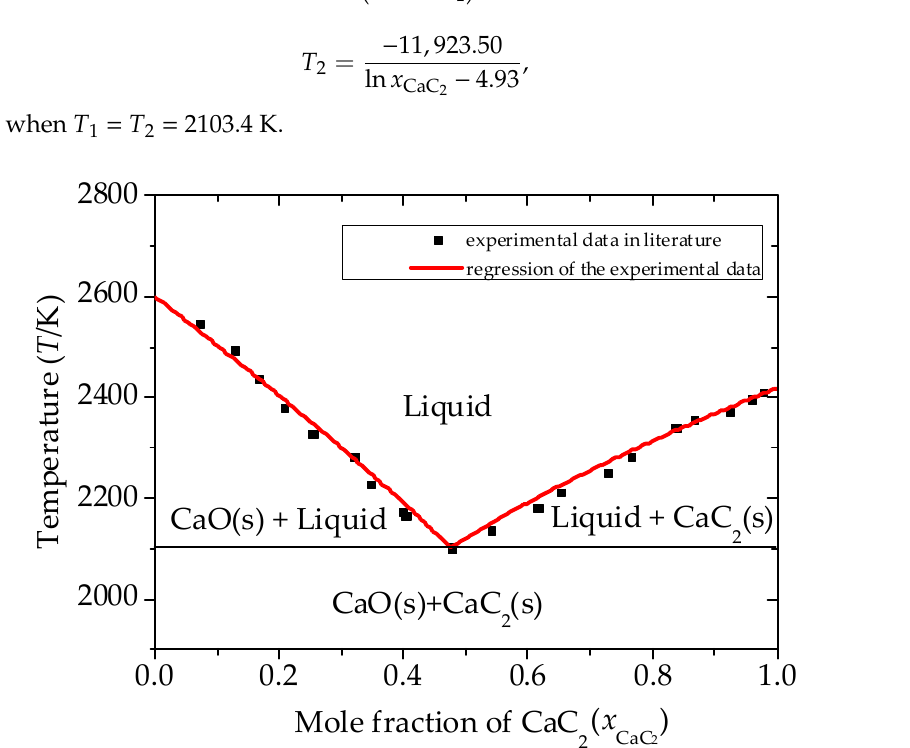
Figure 2. Experimental data fitting of phase diagram of CaC 2 -CaO binary system (Liquid contains CaO (l) and CaC 2 (l)).